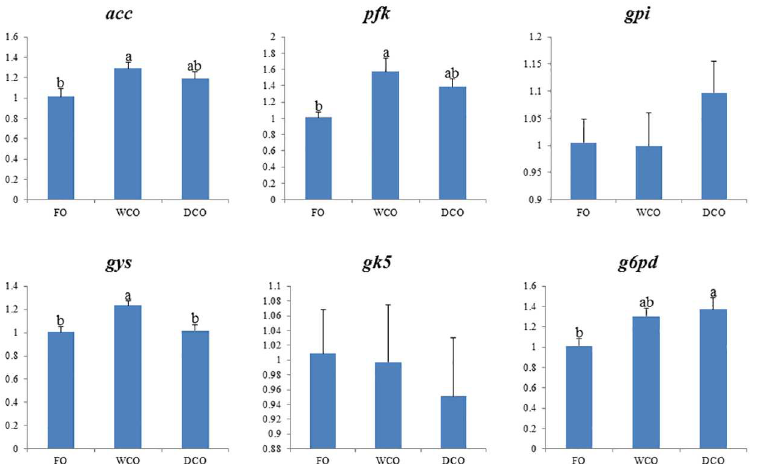
Fig 8. Expression of genes involved in lipogenesis and carbohydrate metabolism in liver of Atlantic salmon as determined by qPCR. Results are normalizedexpressionratios (means ± SEM; n = 6). FO, fish oil diet; WCO, wild type camelinaoil diet; DCO, EPA+DHA camelinaoil diet. Fas , fatty acid synthase; acc , acetyl CoA carboxylase; gpi , glucose-6-phosphate isomerase; gys , glycogensynthase; pfk , phosphofructokinase; pk , pyruvate kinase; g6pd , glucose-6-phosphatedehydrogenase; gk5 , glycerol kinase 5.